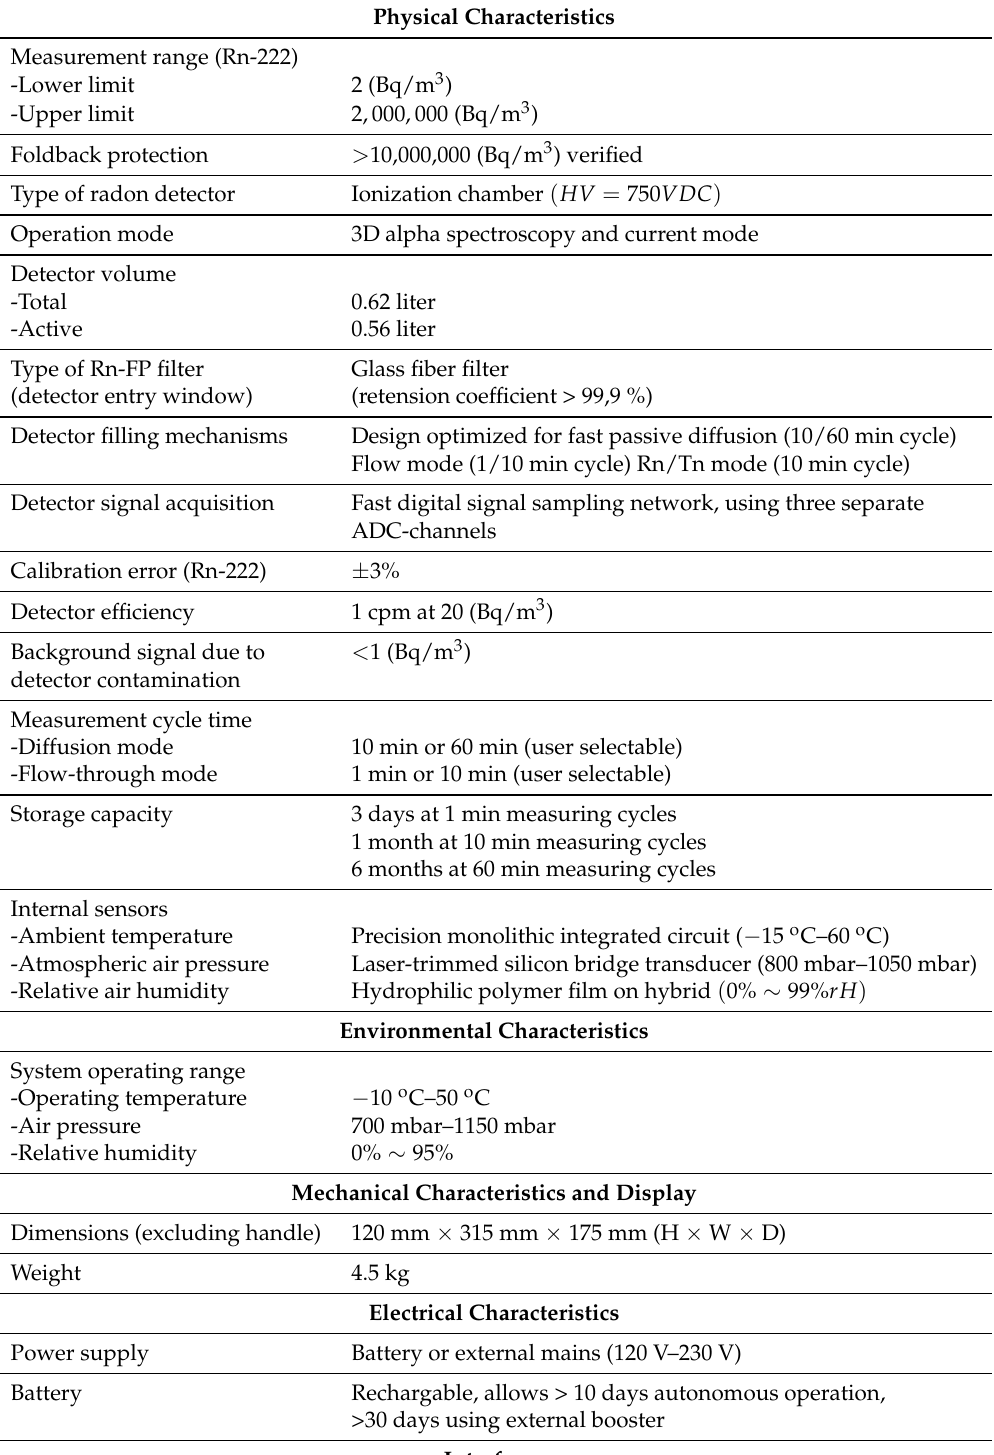
Table 1. AlphaGUARD PQ 200PRO